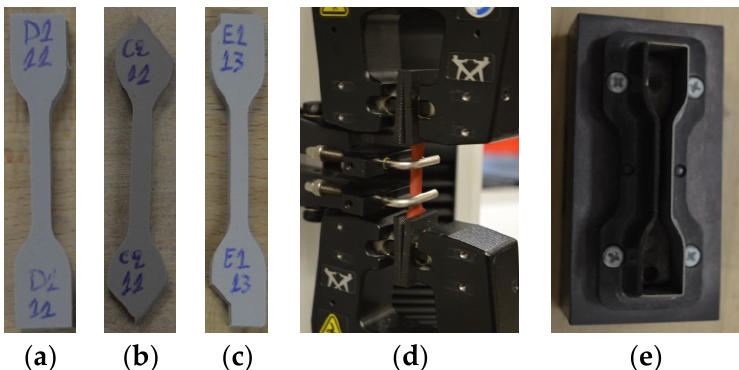
Figure 1. ( a ) Complete dumb-bell test piece, ( b ) and ( c ) examples of incomplete dumb-bell test pieces due to small size of composite insulators sheds, ( d ) symmetrical fixation of an incomplete (at the edges) test piece on the tensile testing machine, ( e ) the type 2 dumb-bell cutting die that was used in this research.